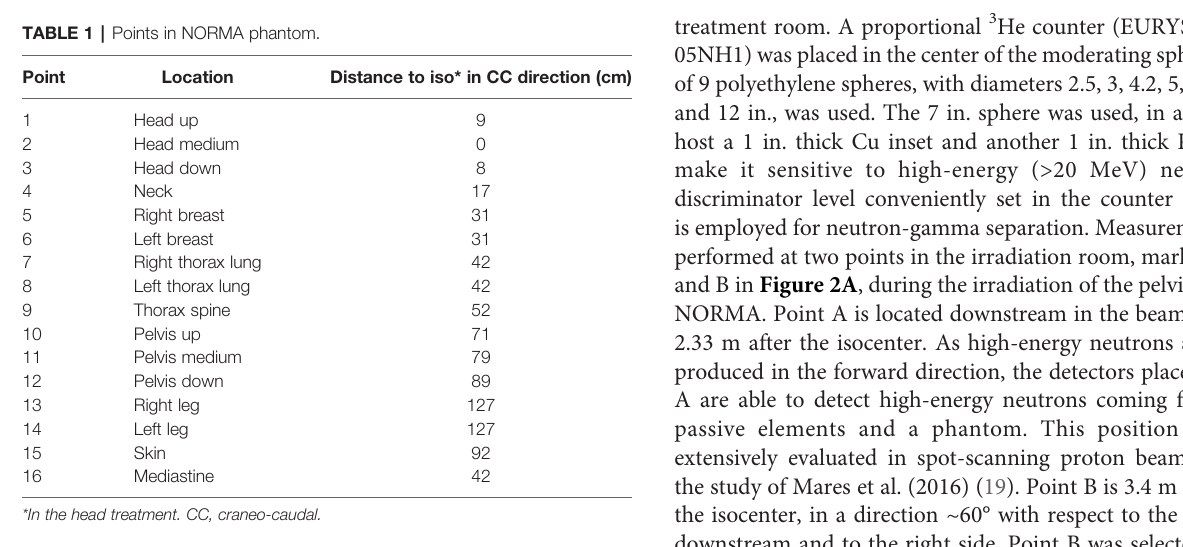
FIGURE 1 | (A) NORMA phantom during the head irradiation in the iThemba facility. (B) Sketch of NORMA phantom and detector